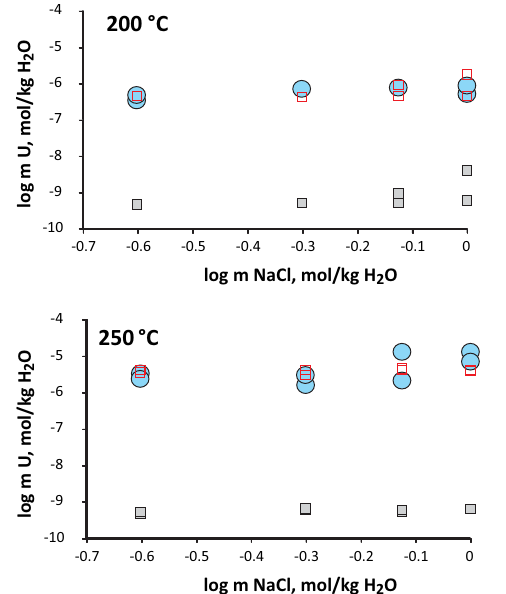
Fig. 1 The data collected on the solubility of U 3 Si 2 and the results of thermodynamic calculations. Concentrations of U determined in solutions co-existing with U 3 Si 2 at 200 (upper) and 250 °C (lower). Experimental concentrations (blue circles) are compared with the predictions for concentrations that should be developed in equilibrium with UO 2 (gray squares) and USiO 4 (open red squares). Error bars are smaller than the symbols on the diagram.